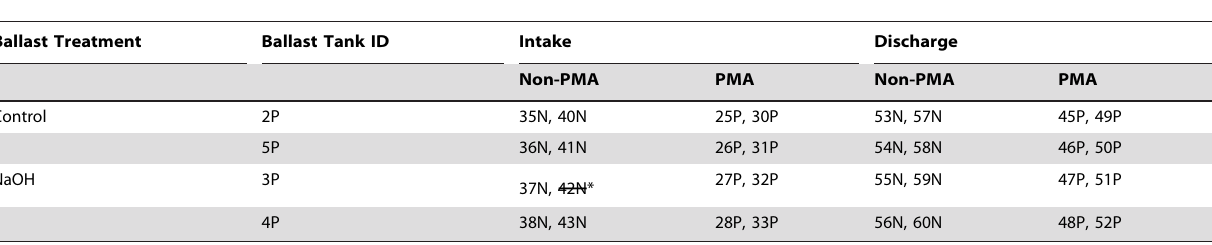
Table 1. Experimental design of alkali ballast water treatment.